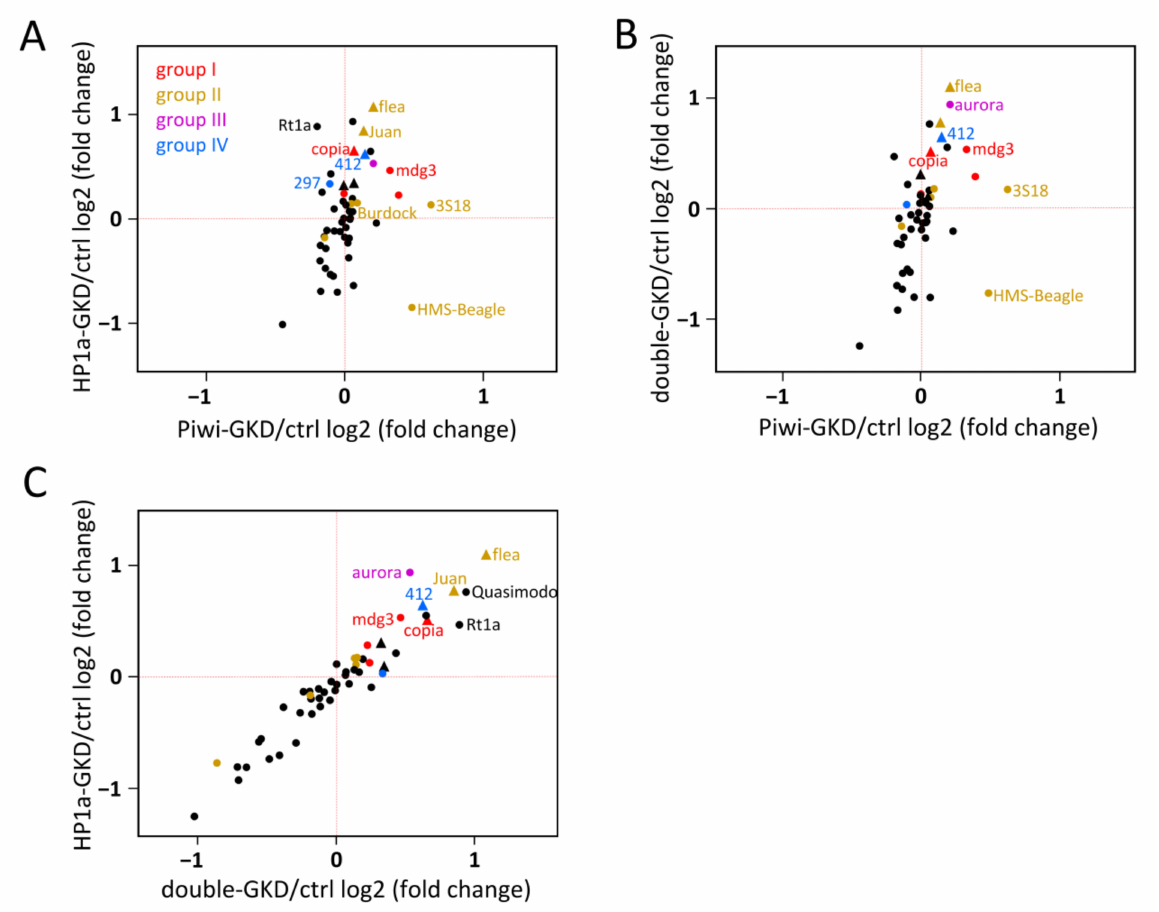
Figure 4. Summarised changes of the transcript levels in genomic loci flanking insertions of different TEs upon Piwi and HP1a germline depletion. ( A ) Scatterplot showing the fold change of the total RNA-seq signals derived from genomic regions flanking (+/ − 3 kb) all insertions of each TE family (log2 sum of RPM) upon Piwi-GKD relative to the control versus the fold change upon HP1a-GKD. The top 50 most abundant TEs in euchromatin of the analysed genome are shown. The TEs of group I are marked in red, group II in dark yellow, group III in purple and group IV in blue. p -values <0.05 for the mean RPM changes of the flanking regions upon HP1a-GKD are denoted by triangles. ( B ) The same for Piwi-GKD versus Piwi/HP1a double-GKD. ( C ) The same for double-GKD versus